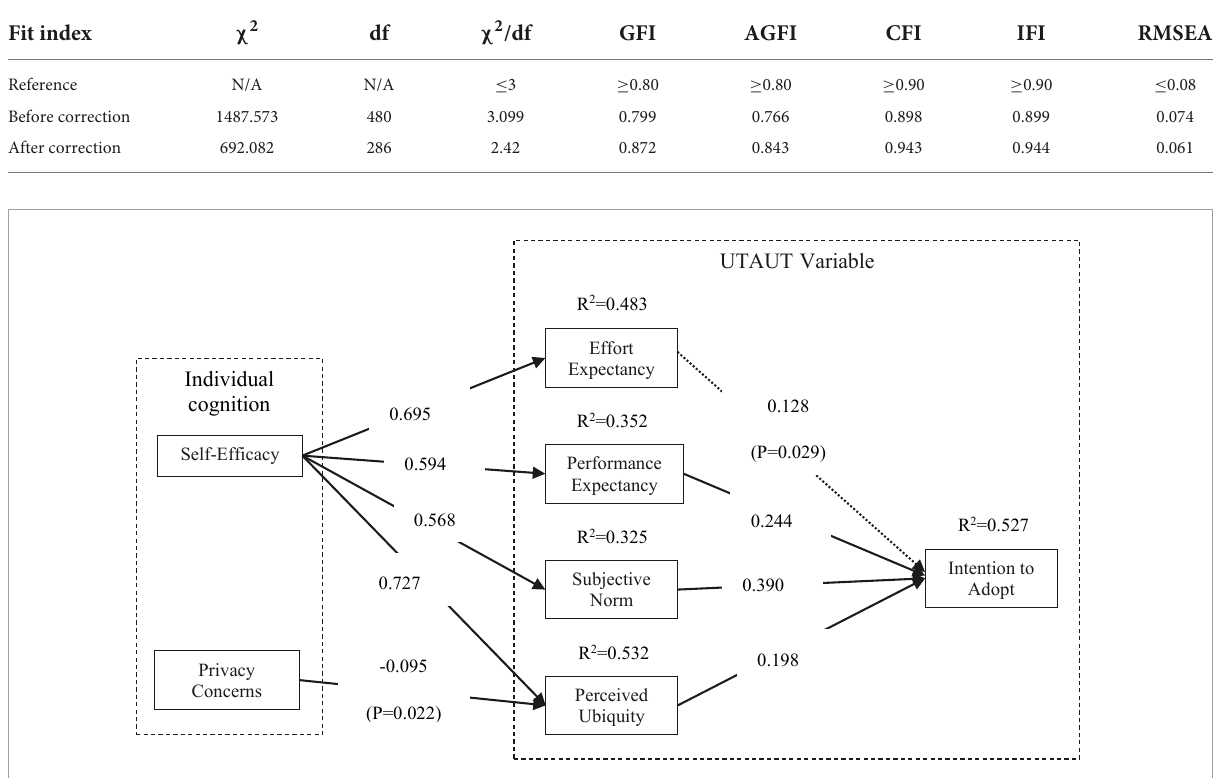
FIGURE4 The model of mHealth users’ intention to adopt after correction (standardized path coefficient). p < 0.05, p < 0.01, p <